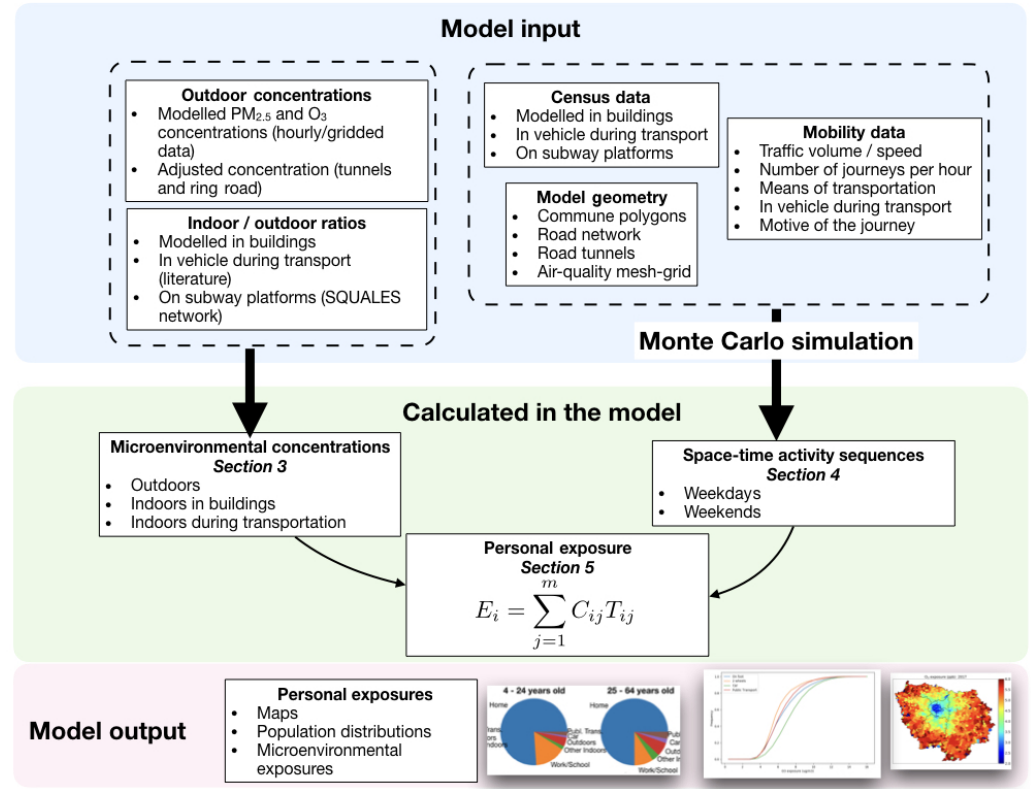
Figure 6. Population density at the commune level in the Île-de-France region (left). Distribution of exposure factors in the sample population (right). Data source: census 2009